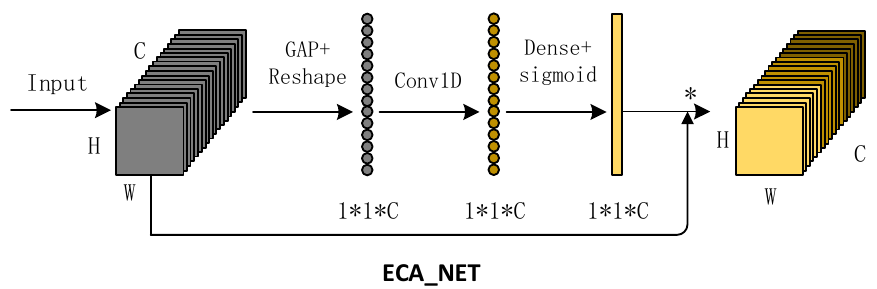
Figure 1. Efficient channel attention network ( ECA-NET) block.